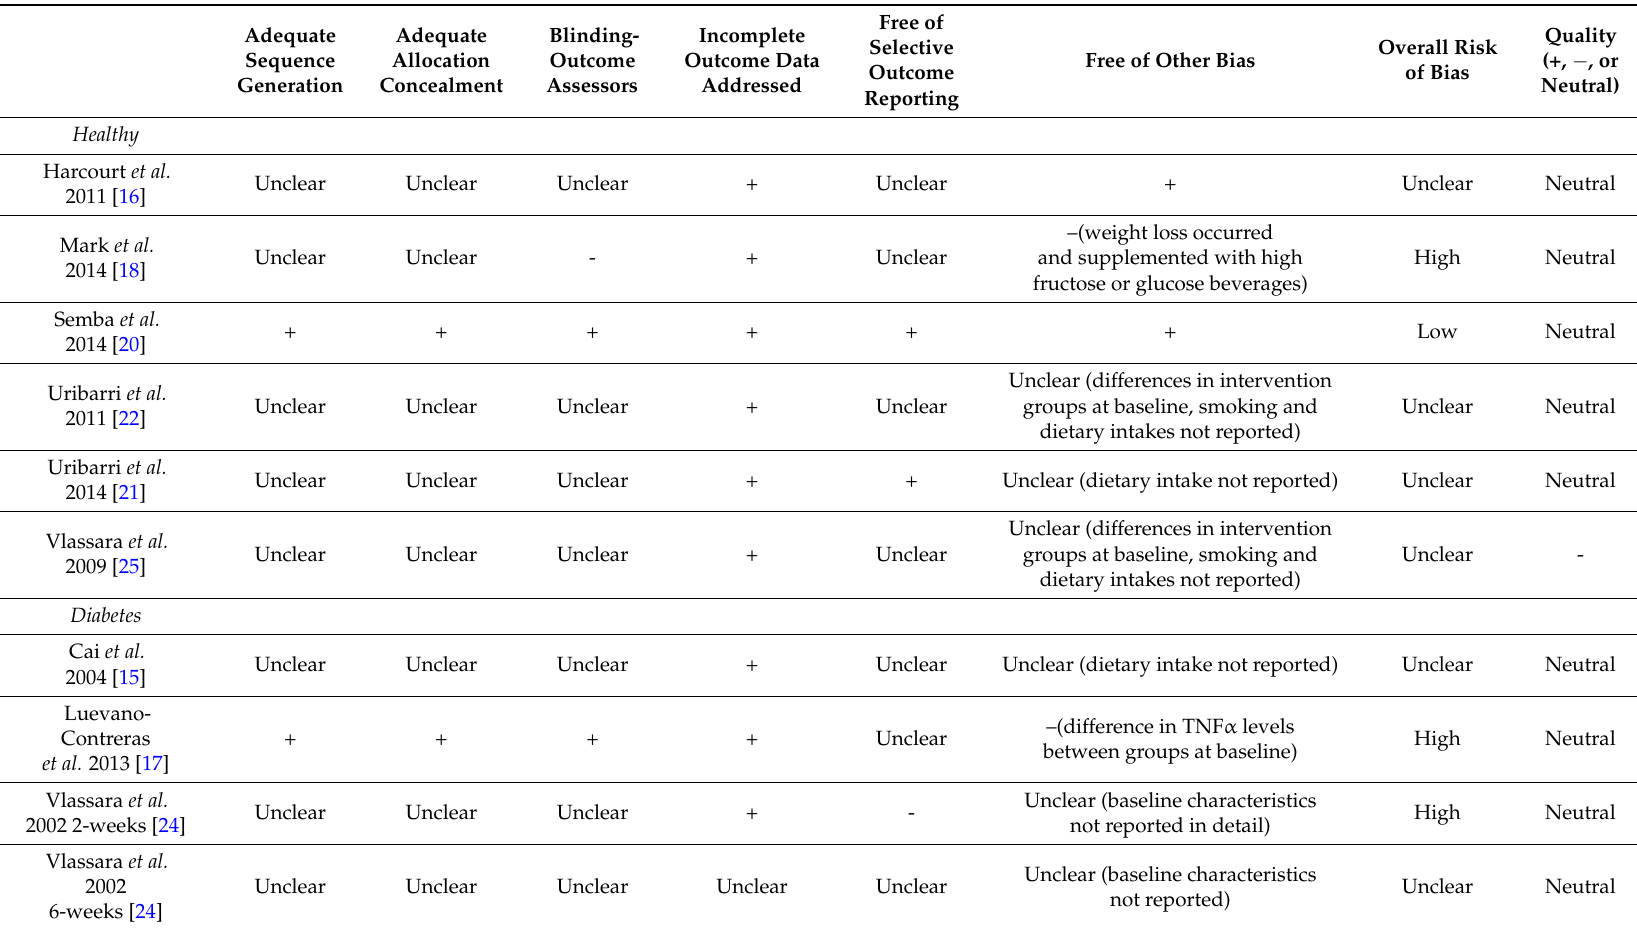
Table 5. Assessment of studies using Cochrane risk of bias tool and the American Dietetic Association quality criteria